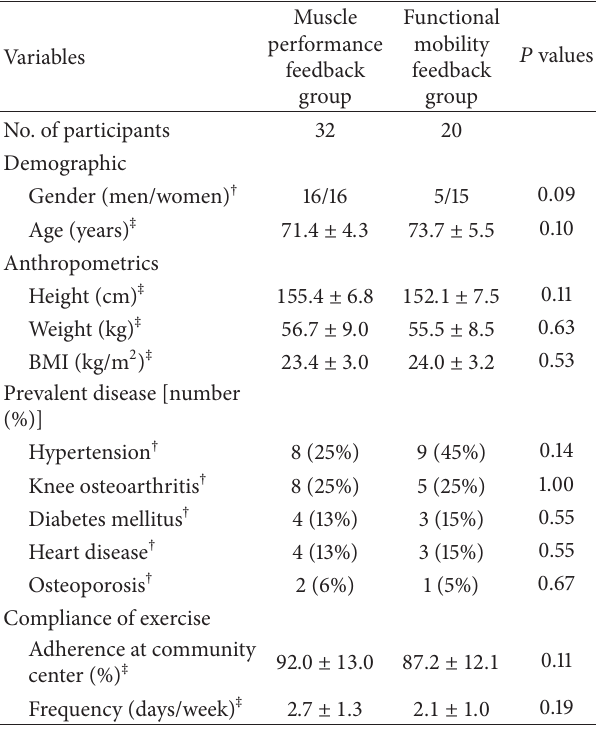
Table 1: Participant characteristics (mean ±